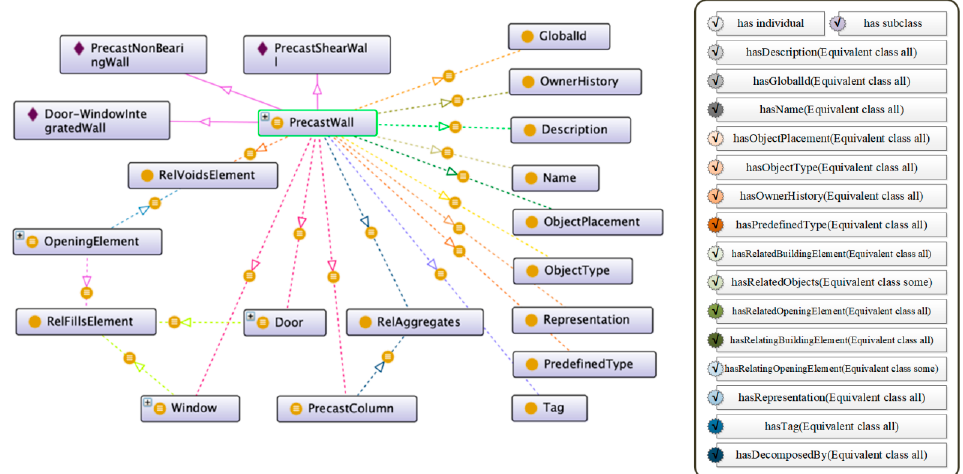
Figure 12. Ontology relationship diagram of prefabricated wall and its domain.